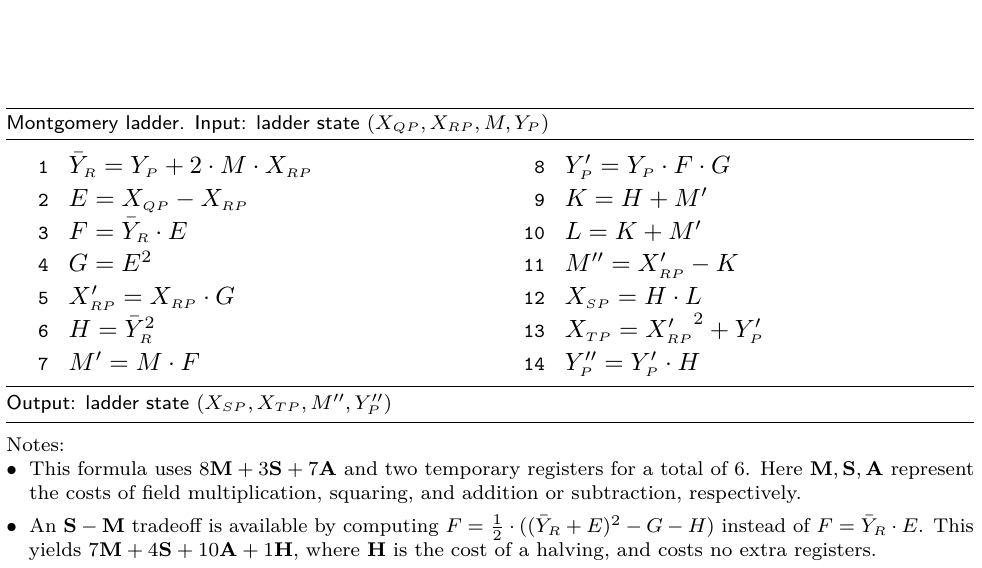
Figure 3: Improved ( X